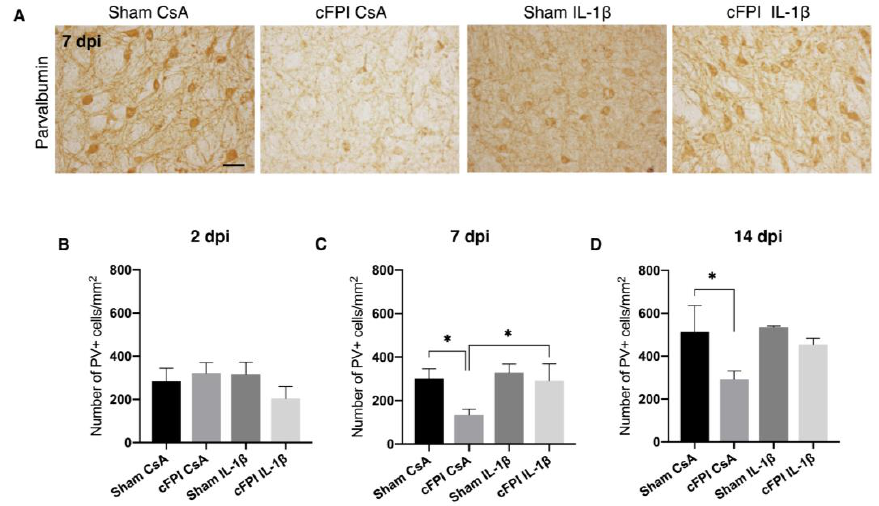
Figure 2. Neutralizing IL-1 β antibody rescues Parvalbumin-positive neurons in the globus pallidus ( A ) Representative images showing PV + neurons in the GP at seven dpi, scale bar 20 µ m. ( B )